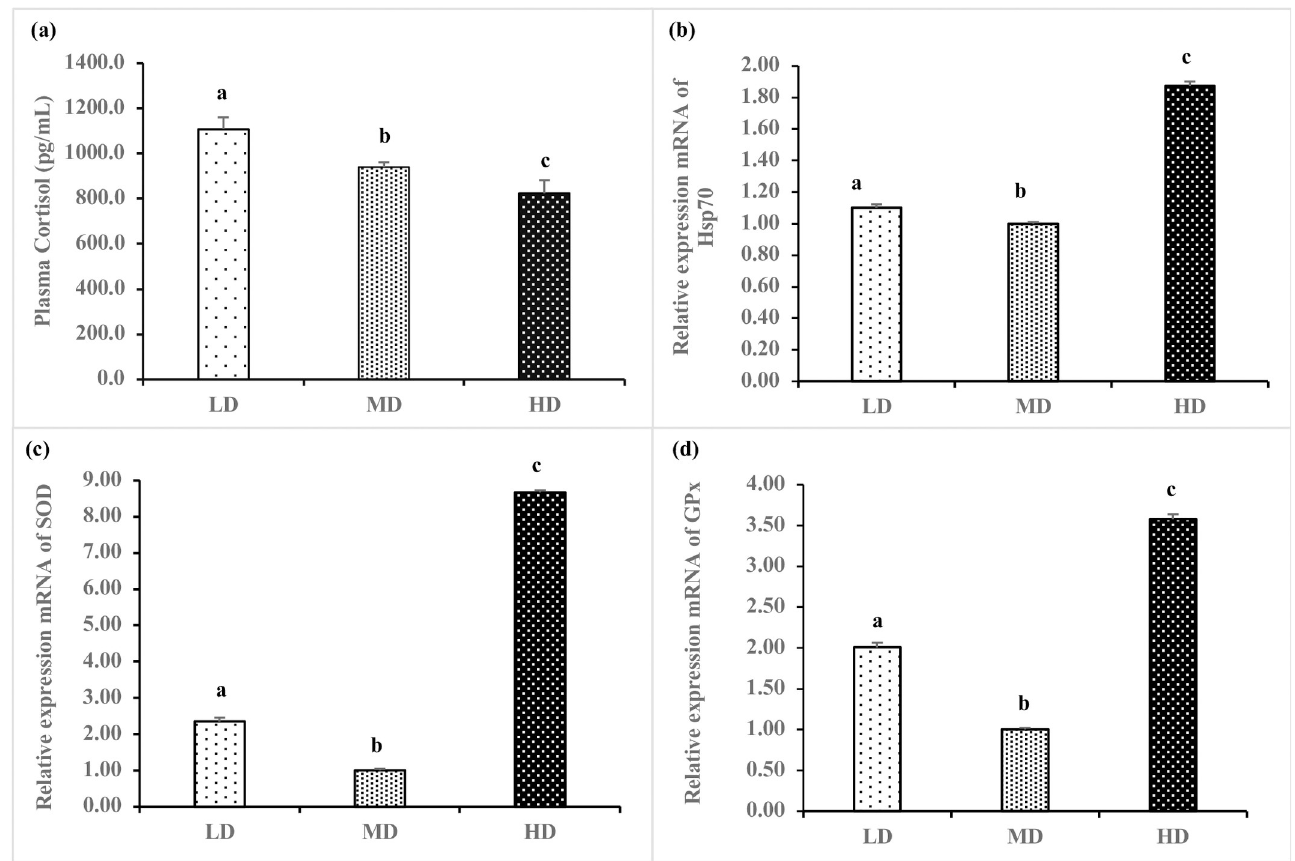
Fig 5. (a) The mean cortisol concentration (pg/mL) of yellow perch reared at different stocking densities, (b) the expression of mRNA Hsp70 in the liver of yellow perch reared at different stocking densities, (c) the expression of mRNA SOD in the liver of yellow perch reared at different stocking densities, and (d) the expression of mRNA GPx in the liver of yellow perch reared at different stocking densities. The data represent the mean ± SD. The groups not sharing common letters are significantly different ( P < 0 . 05 ).